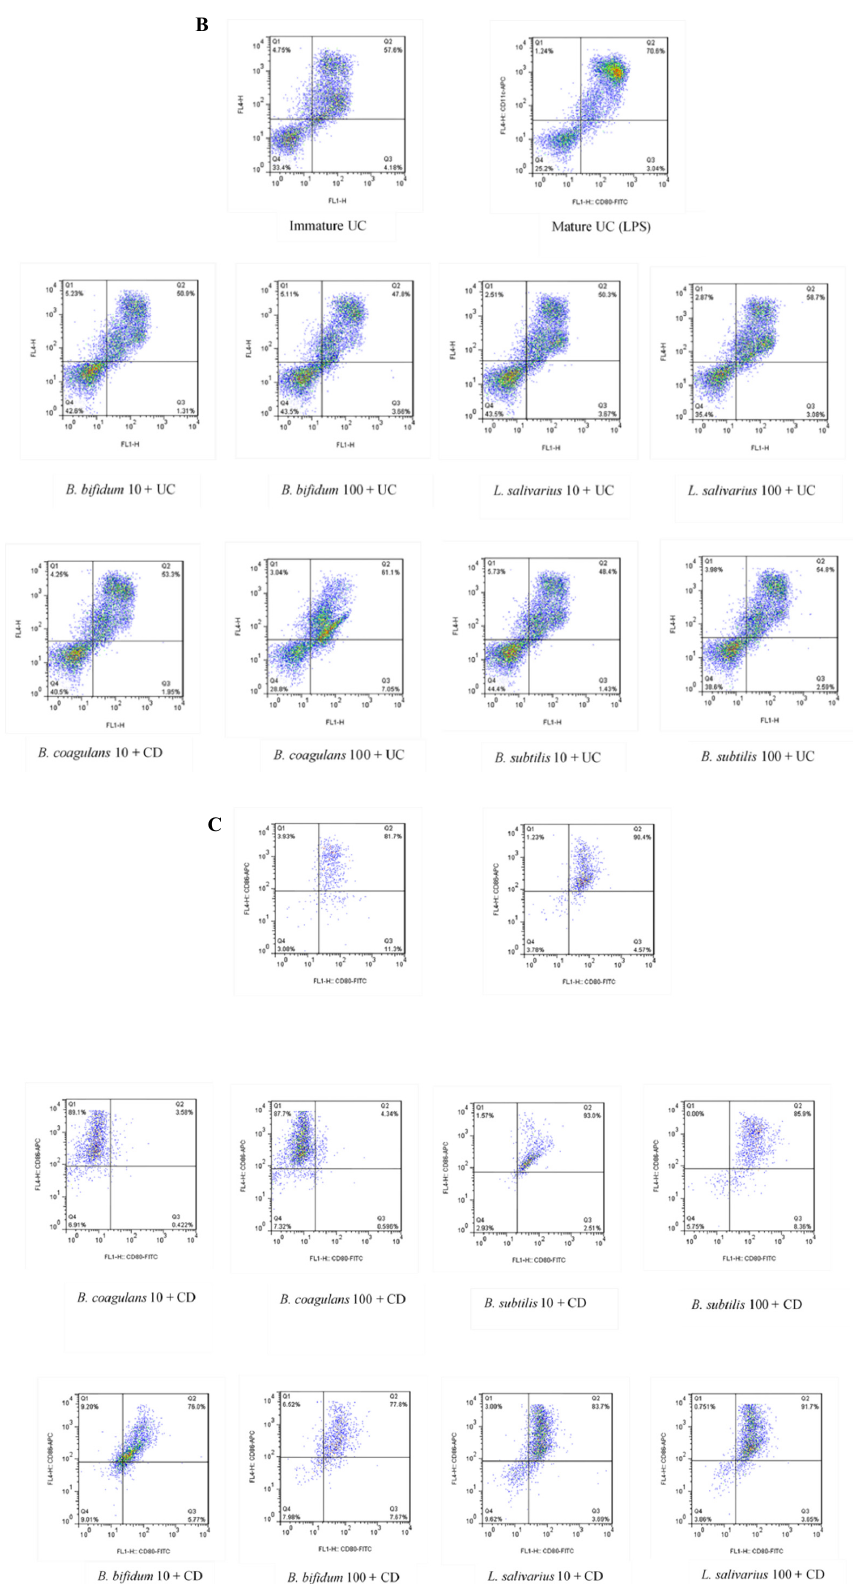
Figure 2. Effects of probiotics on dendritic cells’ (DCs) surface marker expression in maturation pathway after treatment for 24 h. ( A ) (HC); ( B ) (UC); ( C ) (CD). HC: healthy controls, UC: ulcerative colitis, CD: Crohn’s disease.